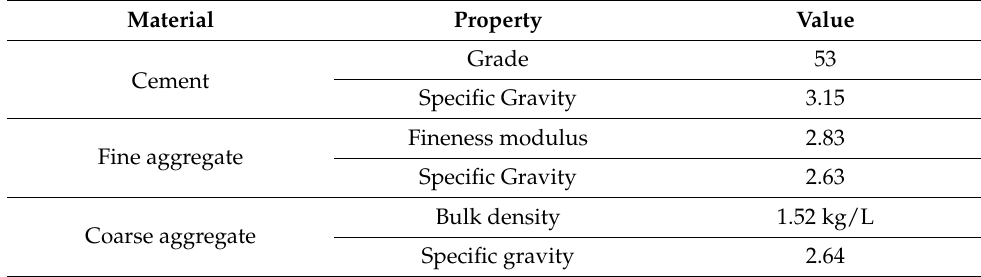
Table 1. Constituent properties of